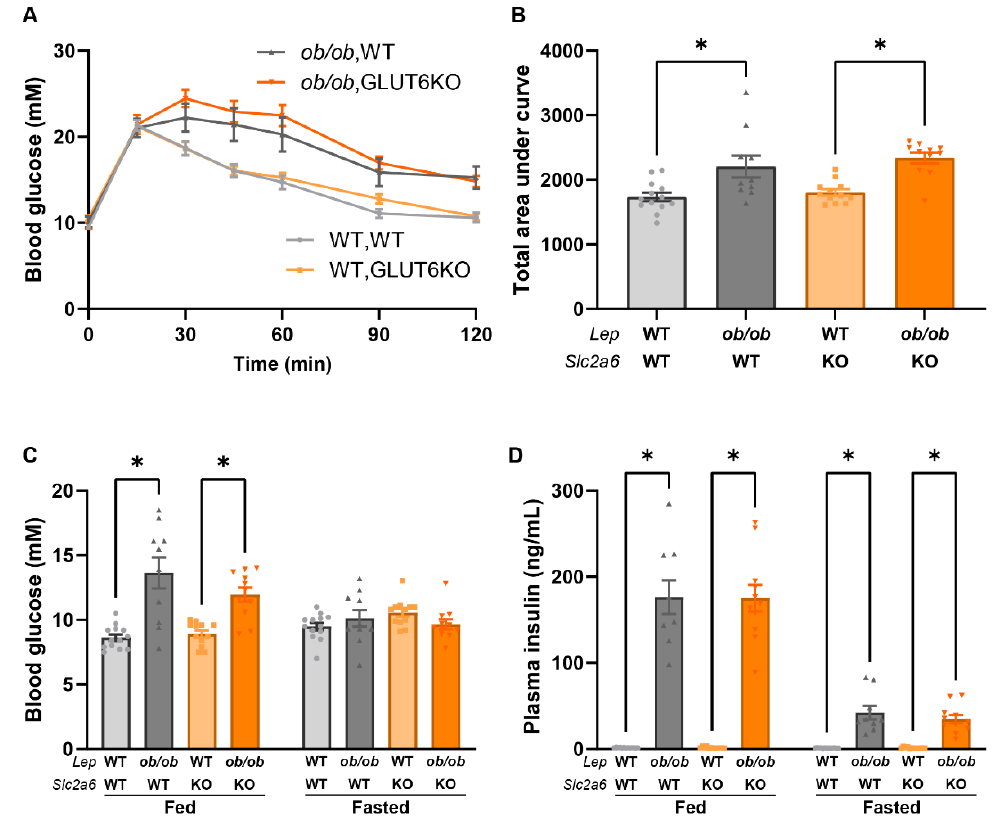
Figure 5. GLUT6 knockout has no effect on glucose tolerance in mice expressing either wild-type or mutant leptin. Male mice at 16 weeks of age were assessed for glucose tolerance ( A , B ), blood glucose ( C ), and plasma insulin ( D ). Genotypes are WT, WT (light grey circles), ob/ob , WT (dark grey triangles), WT, KO (light orange squares) and ob/ob, KO (dark orange triangles) * indicates p < 0.05 by one-way ANOVA. n = 10–13 mice per group.